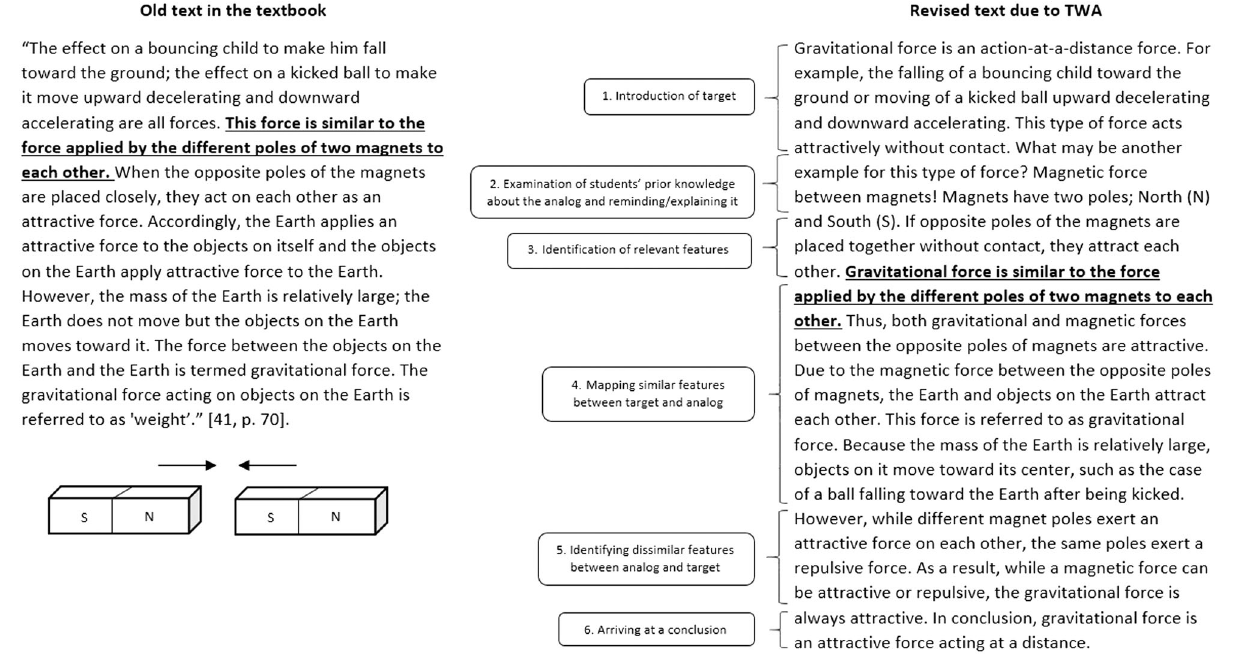
FIG. 3. Revised version of the analogy used in the 7th grade textbook [41] (p. 70) due to TWA. The textbook is originally in Turkish and the analogy was presented with magnet figures. So the text explaining the analogy was translated and the magnet figures were redrawn similar to the ones given in the textbook.